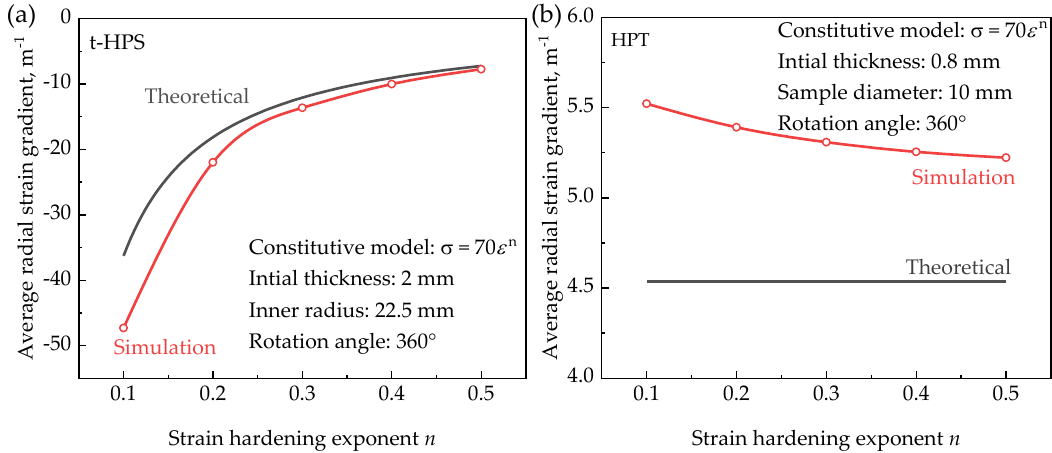
Figure 11. Comparison of the average radial strain gradient as a function of the strain-hardening exponent between simulation close to practical situations and theoretical results in the processed sample without including the edge part, for both t -HPS: ( a ) and HPT ( b ) where the die dimension similar to the reference [8].